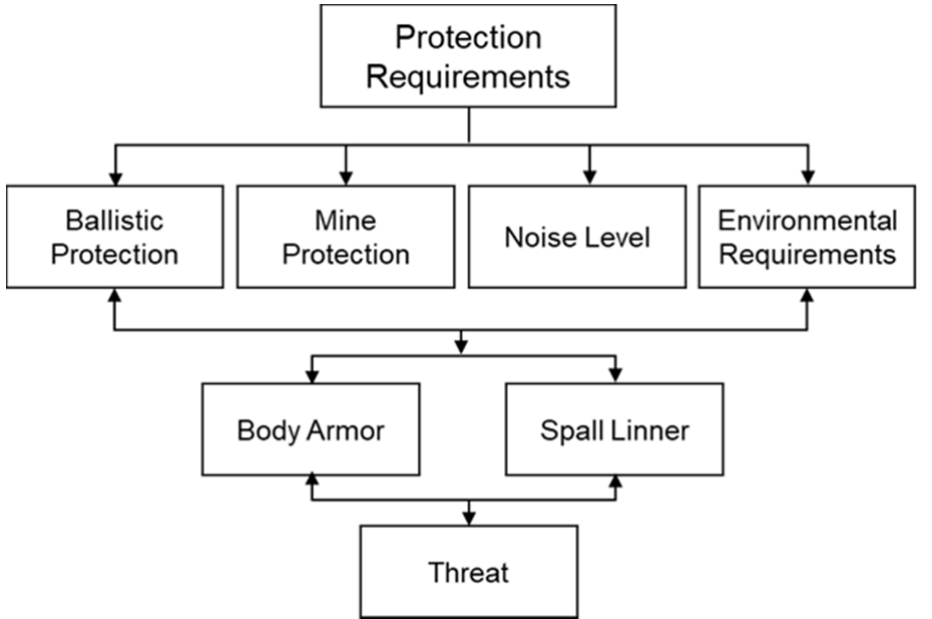
Figure 1. Concept of Threat Protection